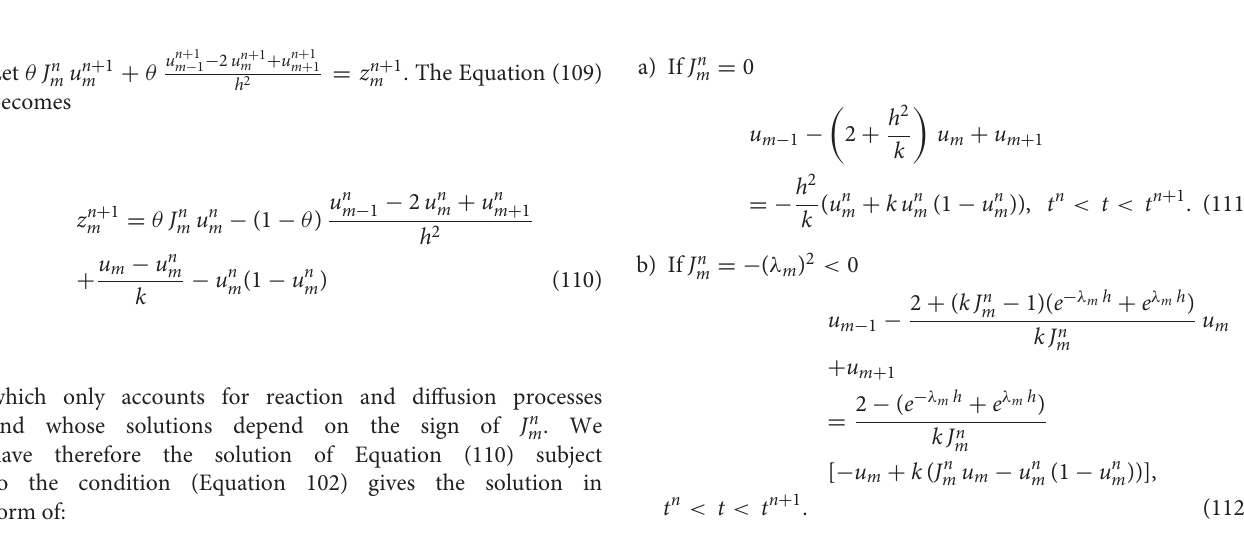
FIGURE 1 | Plot of initial solution, numerical solution of (FTCS), NSFD, and EEFD respectively in (A–C) and exact solution against x at time, T max h 0.01 and optimal value of time step size of k for three different values of ρ namely 1, 10 2 , and 10 4 =